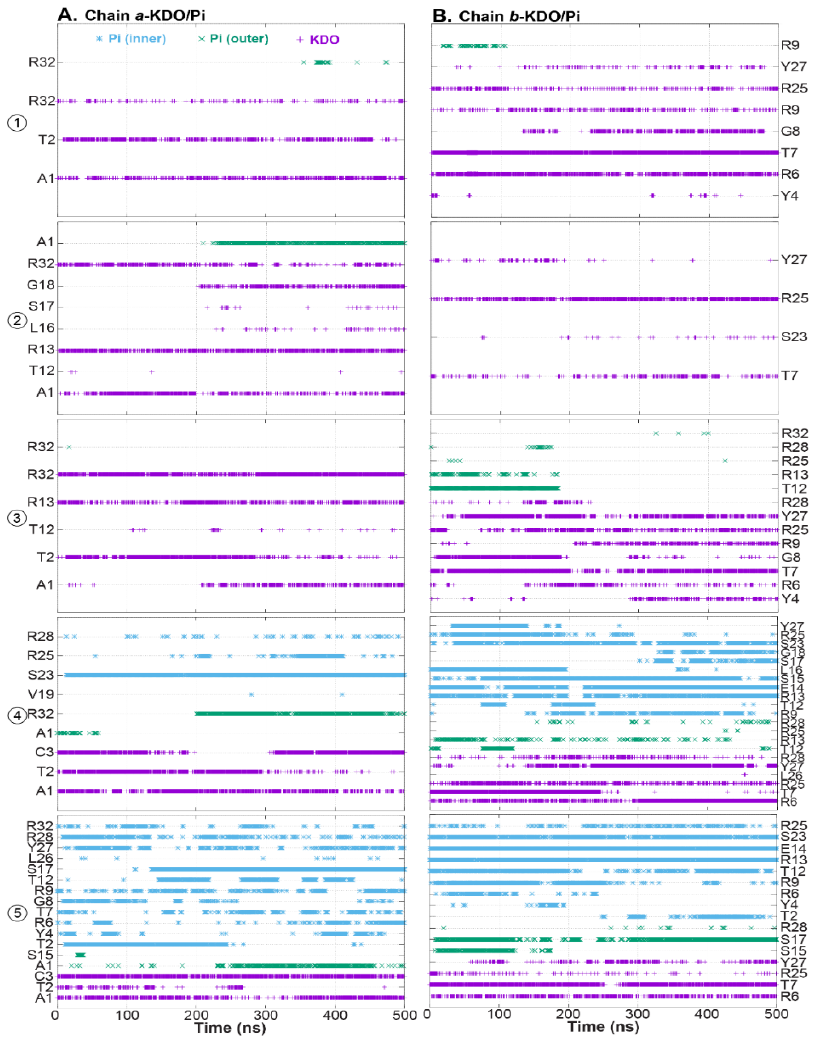
Figure 6. Hydrogen bonds formed between polar moieties of the membrane (KDO and Pi groups) and ( A ) chain a and ( B ) chain b of HD5. Interactions with KDO, Pi of lipid A (Pi(outer)), and Pi of phospholipid head groups (Pi(inner)) are colored in violet, green, and cyan,